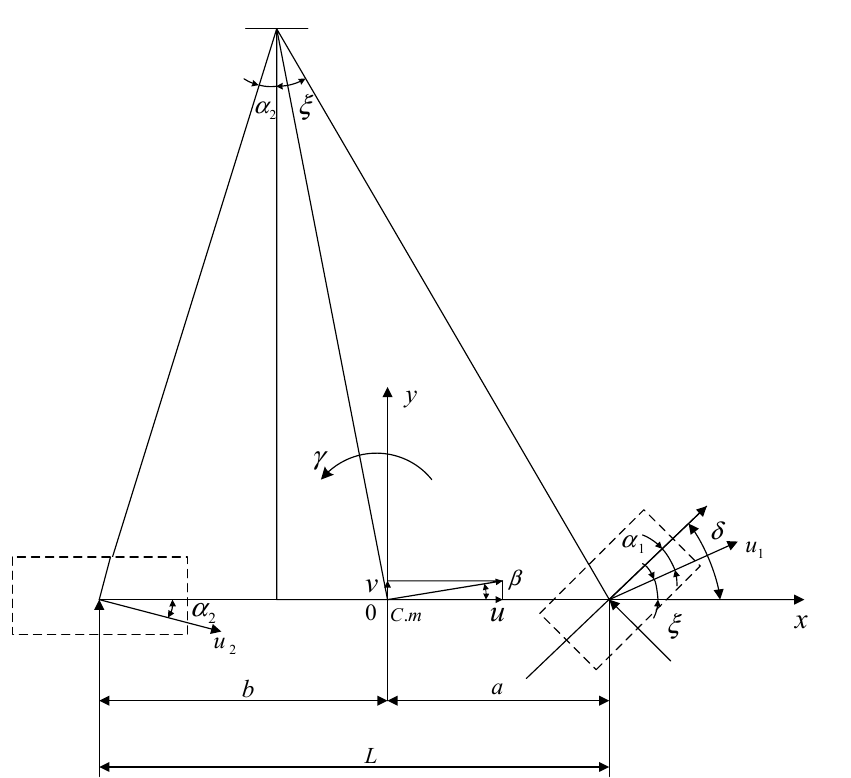
Figure 1. 2-DOF dynamical model. Where α 1 , α 2 are front and rear wheel sideslip angles, respectively; u 1 , u 2 are speeds at the midpoint of automotive front and rear axles, respectively; ξ is the angle between u 1 and the x -axis; L is the wheelbase; u is the forward speed; v is the lateral speed; k 1 , k 2 are the cornering stiffnesses of the front and rear wheels, respectively; a , b are the distances from the vehicle center of gravity to the front and rear axles; δ is the front steering angle; m is the vehicle mass; I z is the equivalent yaw moment of inertia; β is the vehicle sideslip angle; γ is the yaw rate; C . m is the vehicle centroid.